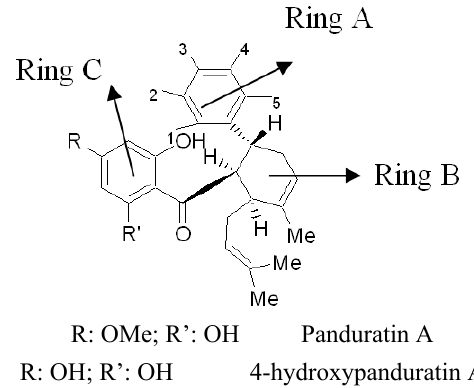
Figure 4. Molecular structures of competitive inhibitors extracted from Boesenbergia rotunda.